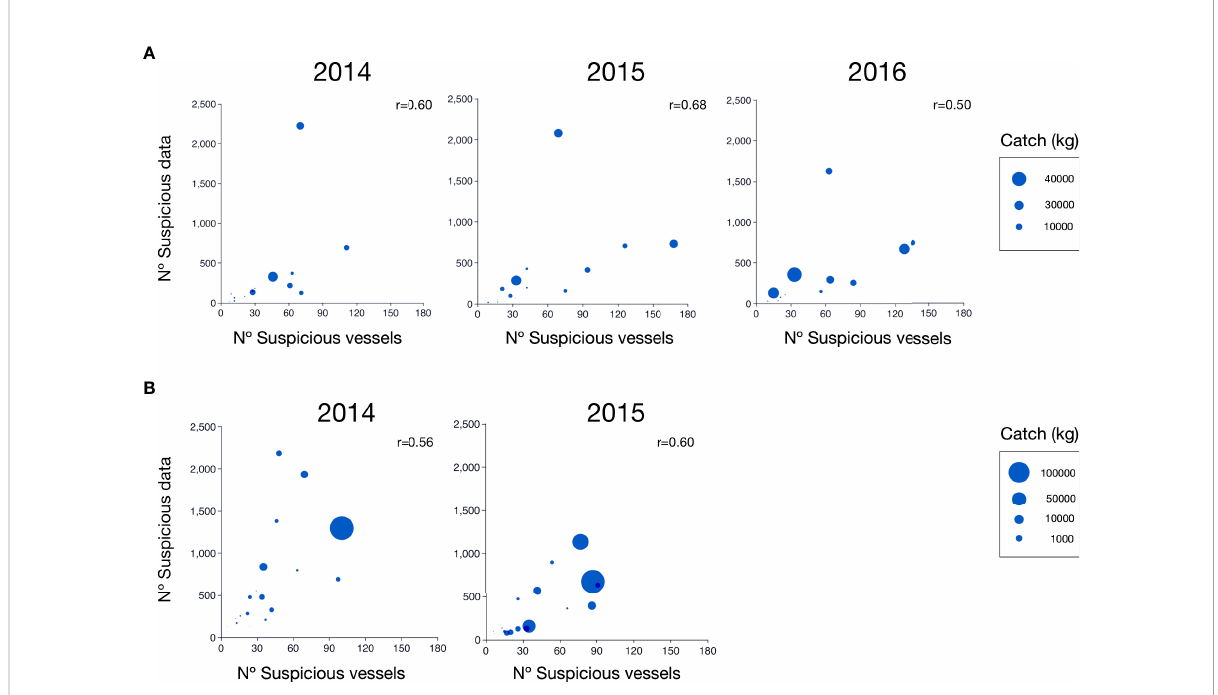
FIGURE 7 Scatter plot between suspicious data and Suspicious vessels for each harbor of non-motorized (A) and motorized (B) canoes. Circle size is related to the size of the total catch in